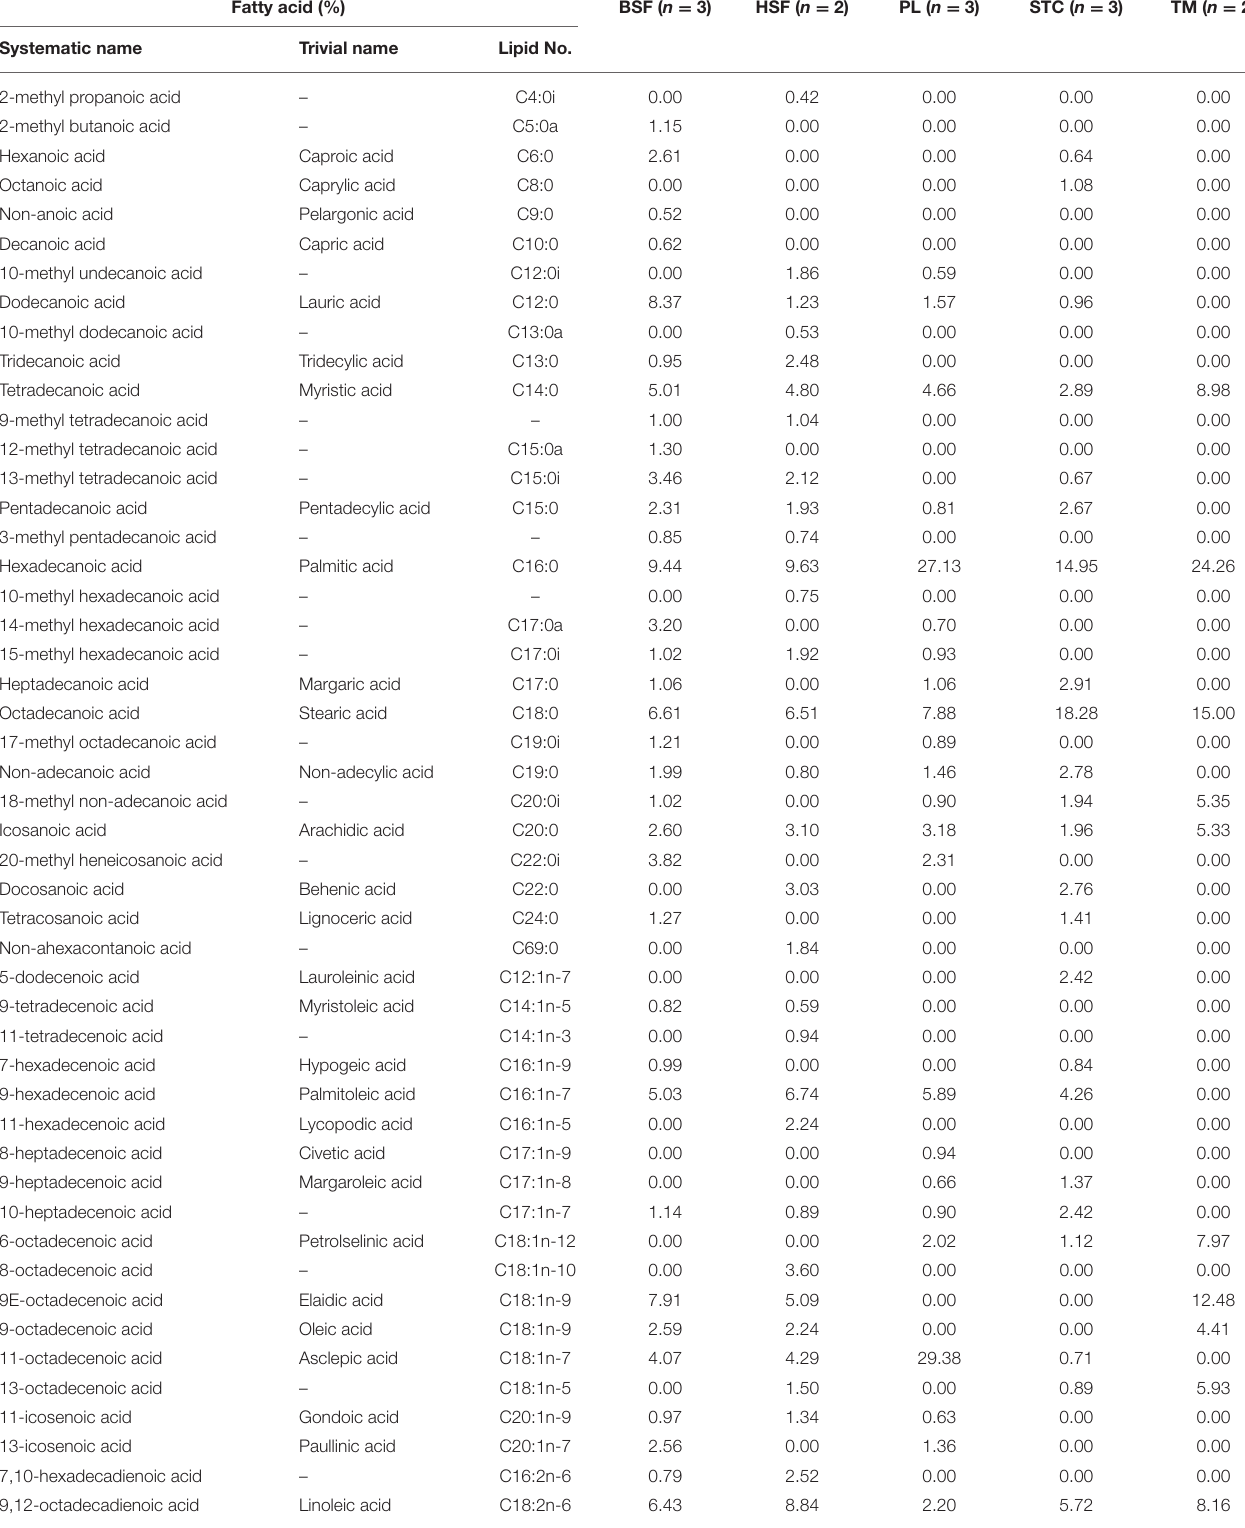
TABLE 2 | Fatty acid profiles of the five analyzed species of edible insect. Fatty acid